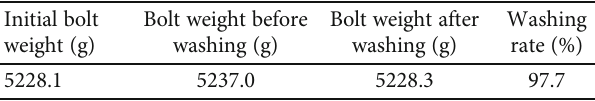
Table 6: Washing rate applying the optimal control factors. Initial bolt Bolt weight before Bolt weight after Washing weight (g) washing (g) washing (g) rate (%) 5228.1 5237.0 Table 7: Washing rate applying the optimal control factors. Rotational Air Washing liquid speed of brush injection injection shaft pressure pressure Mean S- 40.12 N ratio Mean 100.0 response